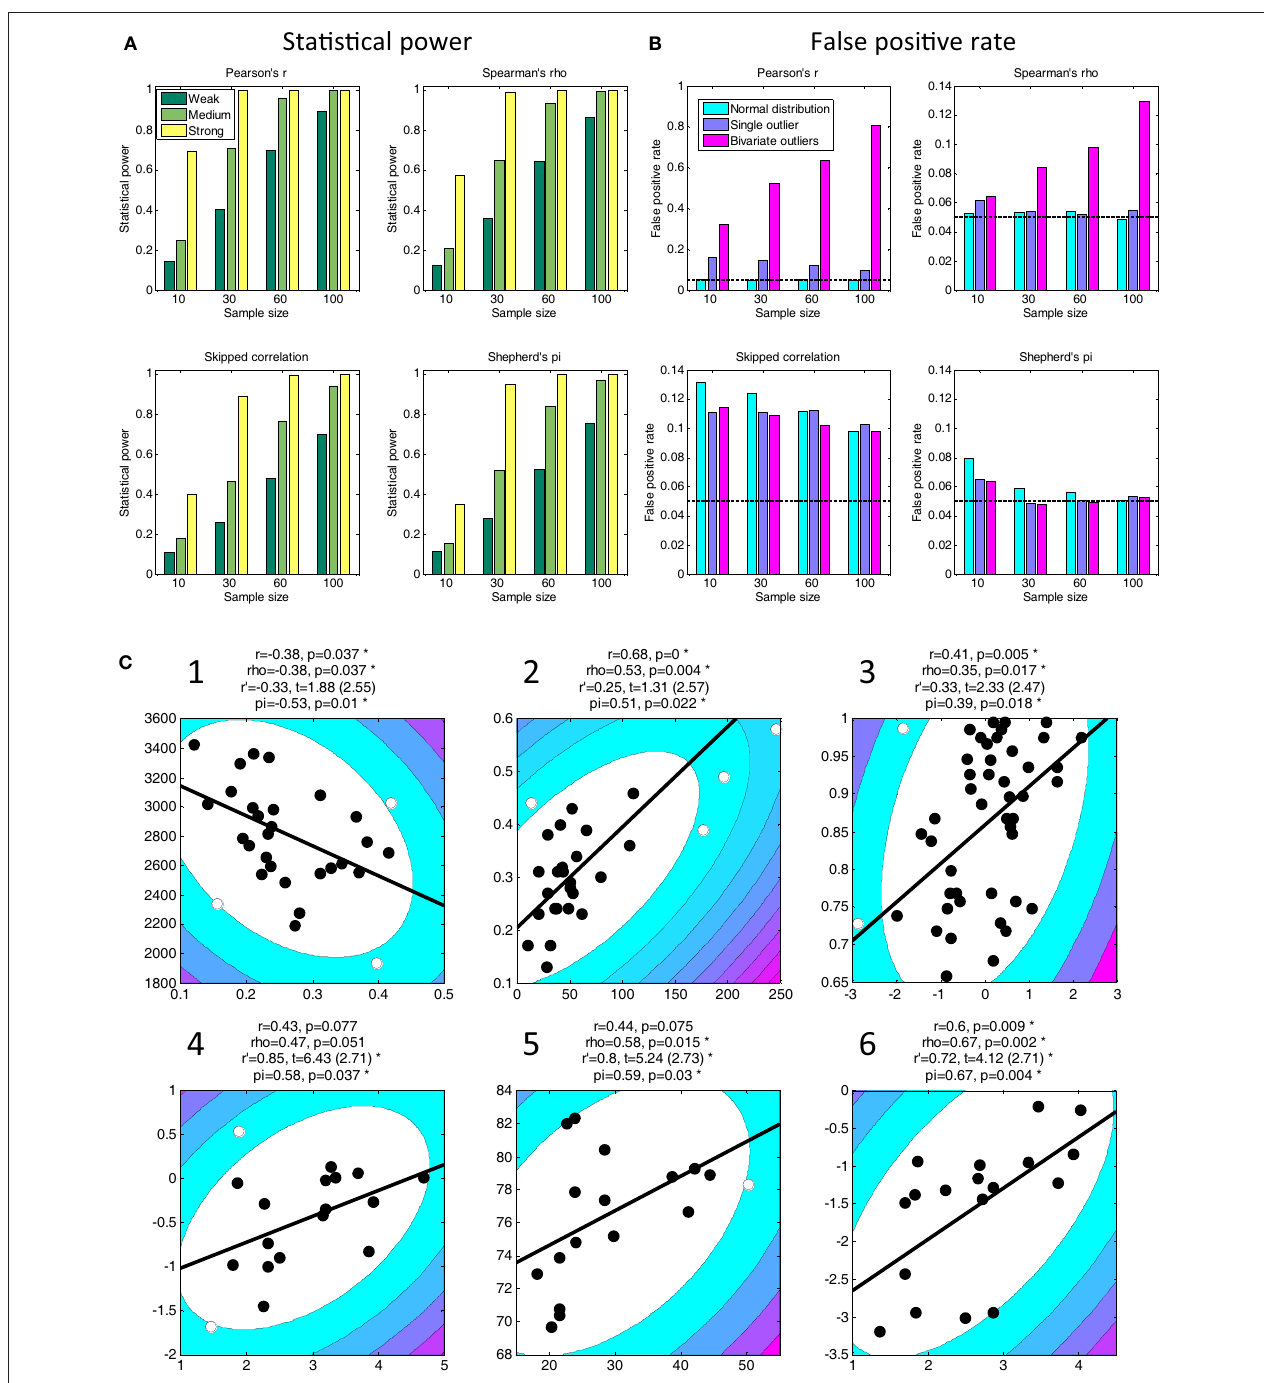
steps of six squared units (purple colors denote greater distances). Filled circles Figure 1 | Statistical power (A) and false positive rates (B) for four denote data included in the correlation, open circles denote outliers (see statistical tests and four sample sizes based on 10,000 simulations (see Appendix 2 for details). The solid line is a linear regression over the data after Appendix 1 for details). Outliers can drastically inflate false positives for Pearson outlier removal. The correlation statistics shown are Spearman’s rho , skipped correlation (note the difference in scale for this test). Skipped correlation (Wilcox, correlation r ′ (critical t in parentheses), and Shepherd’s pi . Asterisks indicate 2005) is generally very susceptible to false positives under all conditions. Only significant results. All p -statistics rounded to third decimal. The freely available Shepherd’s pi provides adequate statistical power and protection against false LIBRA toolbox (Verboven and Hubert, 2005) was used to calculate the skipped positives. The black line in (B) denotes the nominal false positive rate of 0.05. correlation. While the exact estimates of the t -statistic differ between R and (C) Replot of data shown in Rousselet and Pernet’s Figure 2. The contour lines MATLAB the conclusions about significance for these tests are indicate the bootstrapped Mahalanobis distance D from the bivariate mean in s